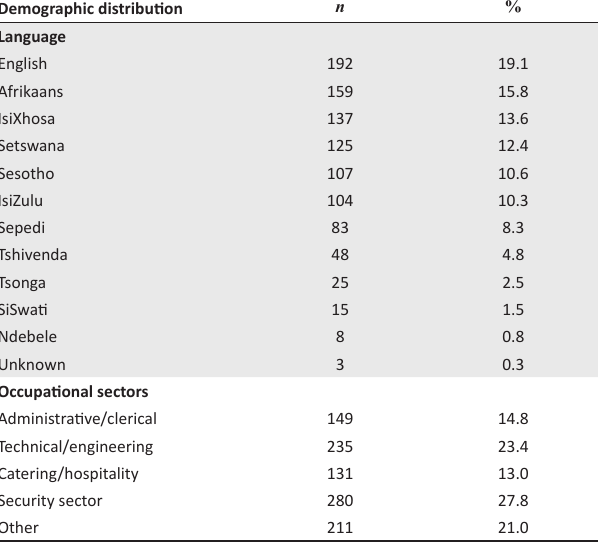
TABLE 2: Sample distribution across home language and occupational